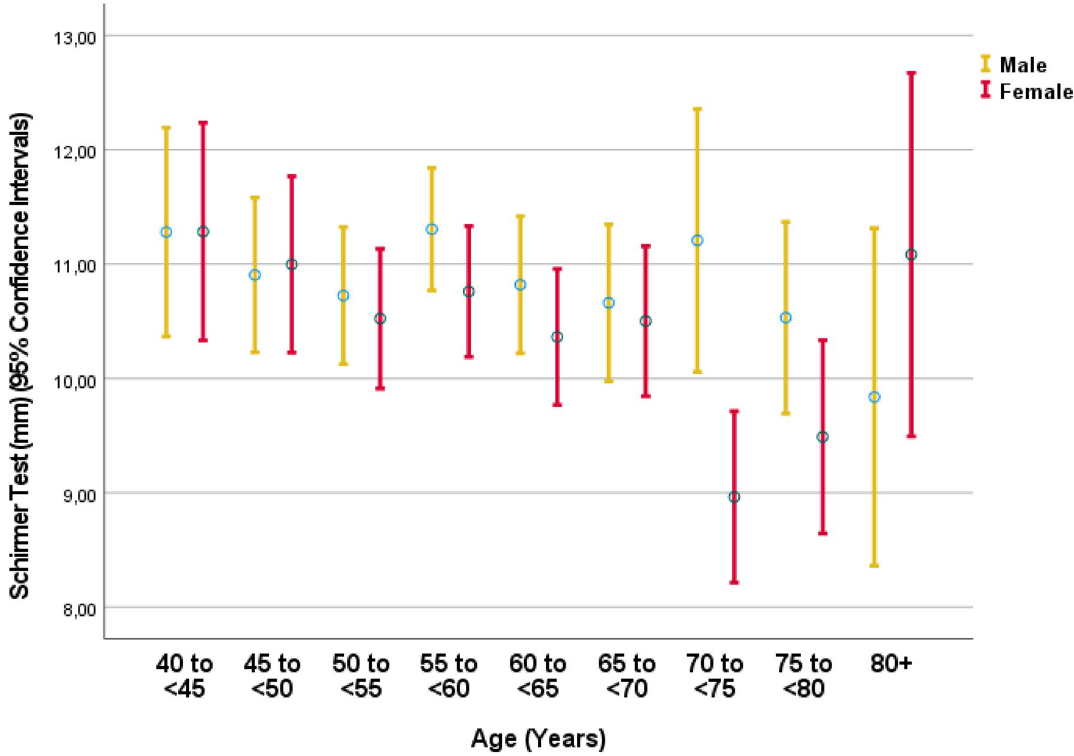
Figure 1. Graph showing the distribution of the Schirmer´s test result stratified by age and sex in the Ural Eye and Medical Study.